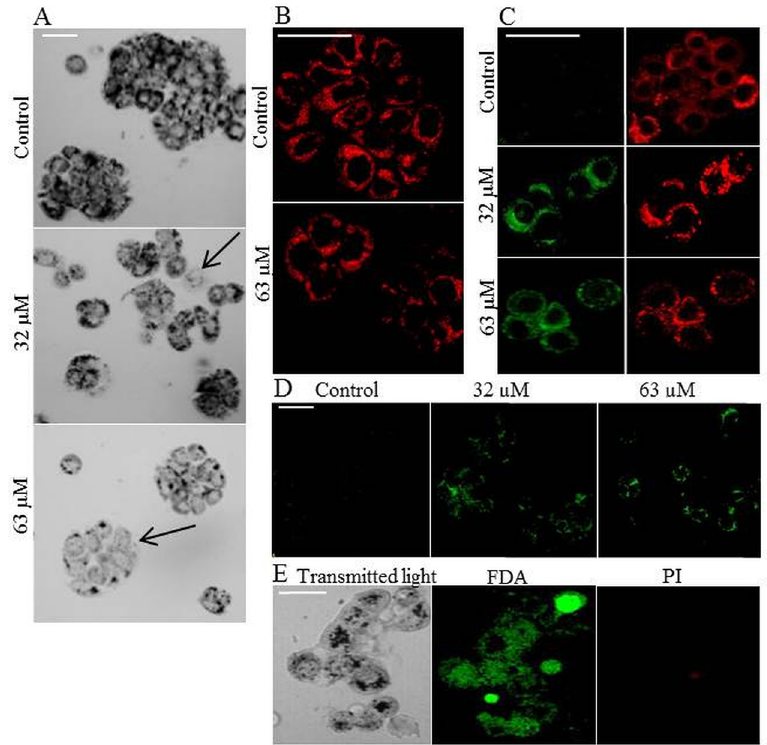
Fig 4. Effect of Selol on MTT reduction. (A) Microscope images of formazan crystals in HT-29 cells. Cells were incubated with 32 and 63 μ M Selol for 24 h. Microscope images were recorded after 3 h of reduction of MTT. Black dots indicate formazan crystals. The arrows indicate a cell without formazan. (B) HT-29 cell mitochondria after 24 h incubation with Selol. Cells stained with the MitoTracker 1 Deep Red. (C) Microscope images of Selol-induced changes in mitochondrial membrane potential ( ΔΨ m). HT-29 cells were incubated with 32 and 63 μ M Selol and stained with MitoLight dye, which stains mitochondria in a membrane potential- dependent fashion. Changes in the mitochondrial membrane potential ΔΨ m were detected by confocal microscopy. Left image presents the detection of monomers (green fluorescence), indicating the presence of depolarized mitochondria. Right image presents the fluorescence of the aggregates (red fluorescence), indicating functional, polarized mitochondria. (D) Microscope images of the intracellular reactive oxygen species (ROS) induction by Selol (green fluorescence). HT-29 cells were incubated with 32 and 63 μ M Selol and stained with the ROS-sensitive dye DHR123. (E) On the left: Microscope images of formazan crystals in HT-29 cells incubated with 63 μ M Selol for 24 h. On the right: FDA/PI staining of HT-29 cells incubated with 63 μ M Selol for 24 h. Microscope images were recorded after 3 h of reduction of MTT. Black dots indicate formazan crystals, green fluorescence denotes living cells stained with FDA, and red fluorescence denotes dead cells stained with PI. Scale bar = 50 μ